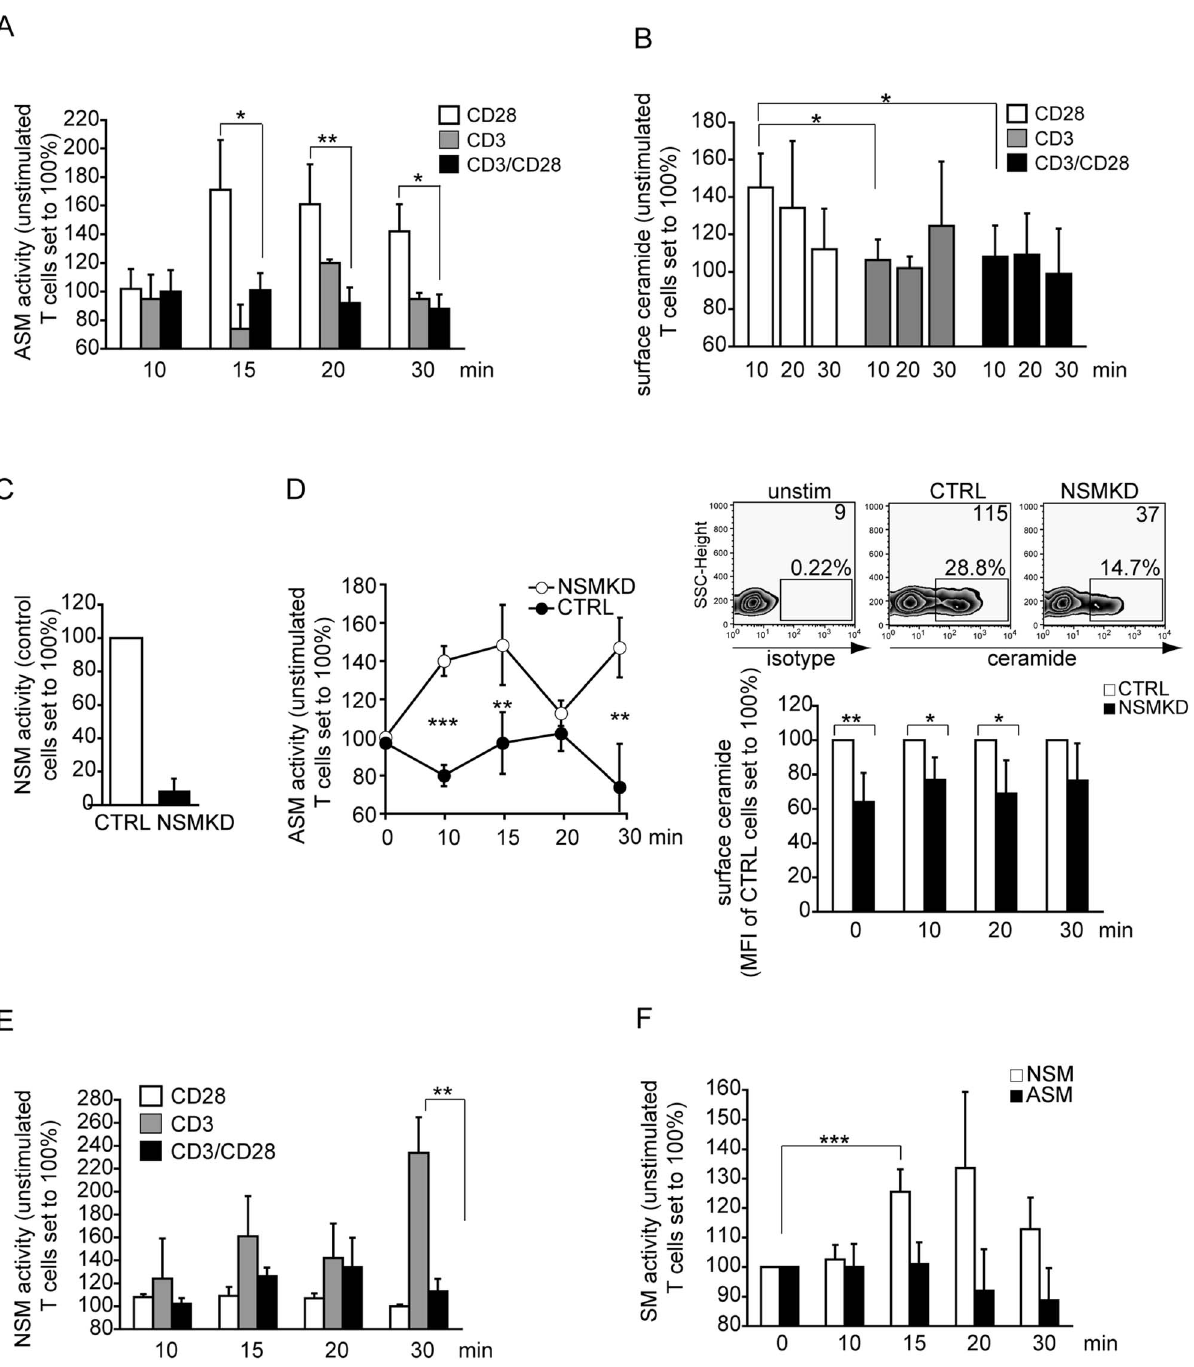
Fig. 1. ASM activation is ablated, while NSM activity is induced early in co-stimulated primary human T cells. A. ASM activity was determined in membrane extracts of T cells activated by a -CD28, a -CD3 or a -CD3/CD28 over time. B. Surface ceramide was detected on T cells activated by ligation of CD3, CD28 or CD3/CD28 by flow cytometry C. NSM activity in membrane extracts of T cells 96 h following transfection of control (CTRL) or NSM2 siRNA (NSMKD). D. ASM activity in membrane extracts of a a˜CD3/CD28 co-stimulated T cells (left) and extrafacial ceramide display (FACS staining) (right, upper graphs: unstimulated, CTRL or NSMKD T cells, upper right corner values represent mean fluorescence intensities; bottom graph: kinetics of ceramide surface display on CTRL versus NSMKD co-stimulated T cells. E. NSM activity was determined in membrane extracts of T cells activated by a -CD28, a -CD3 or a -CD3/CD28. F. ASM and NSM activity were determined over time in a -CD3/CD28 co-stimulated T cells.